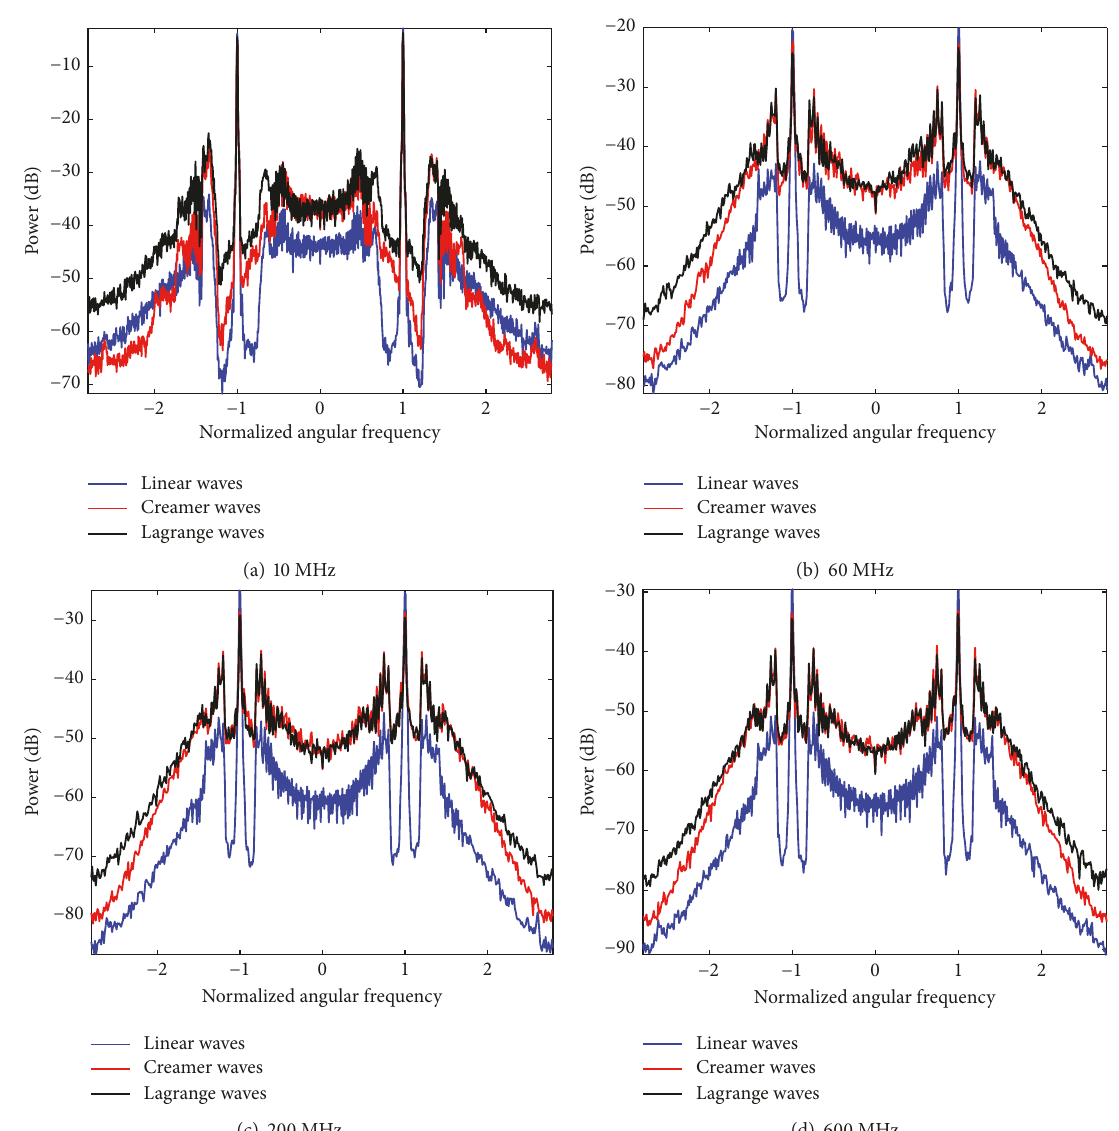
Figure 10: Doppler spectrum comparison between linear and nonlinear waves in HF/VHF/UHF bands. The wind speed is 10 m/s, and the Doppler frequency is normalized by the Bragg frequency 𝜔 𝑏